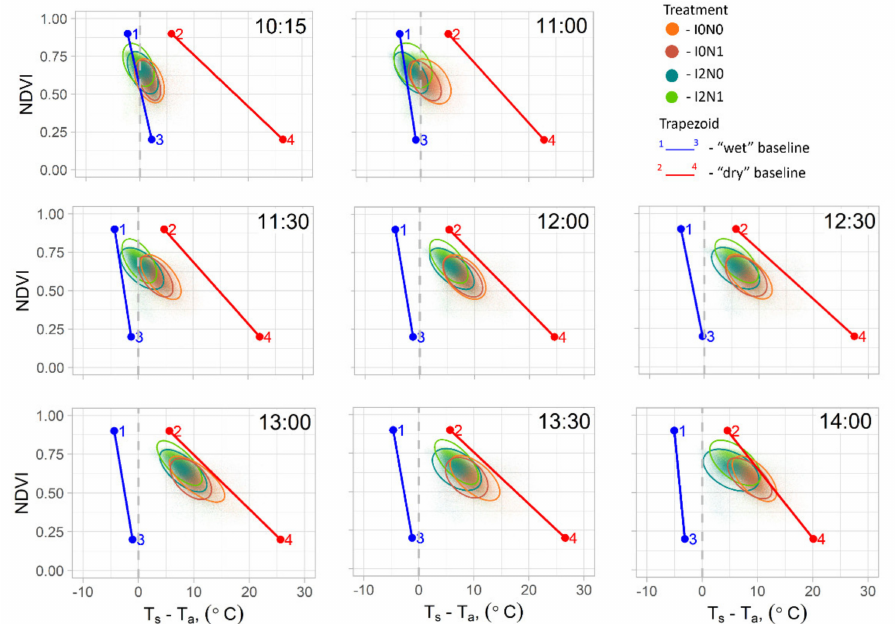
Figure 5. Vegetation index/temperature trapezoids for the winter wheat fields in Denmark on 6 June 2018. I0, I1 and I2 are minimum, optimum and full irrigation, respectively. N0 and N1 are without and with additional fertilization.